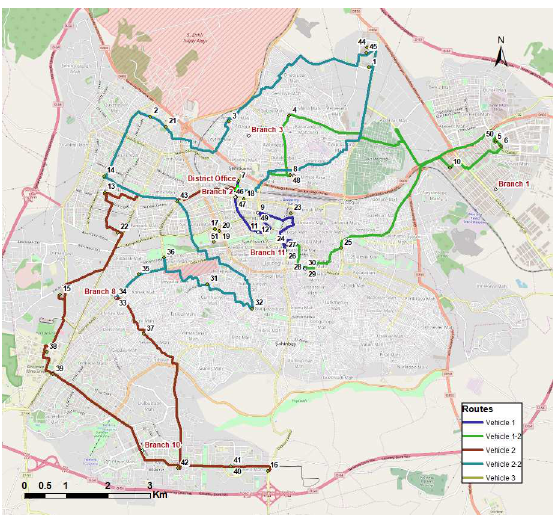
Figure 6. Solution of GB-1.